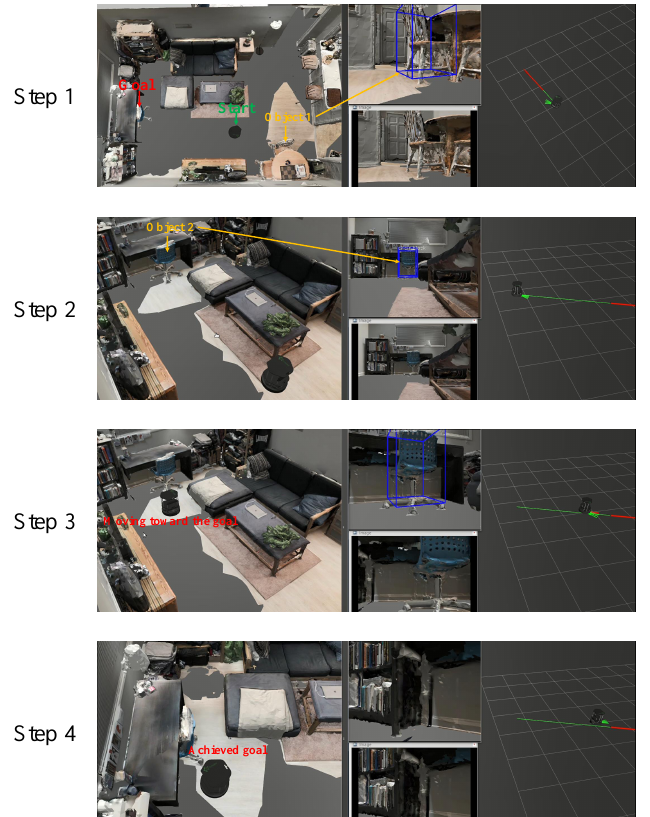
Figure 18. SRs and SPLs results for MSMRL, ANS, NTS, and our method on simulation scenarios. ( a ) Results of SRs; ( b ) Results of SPLs.